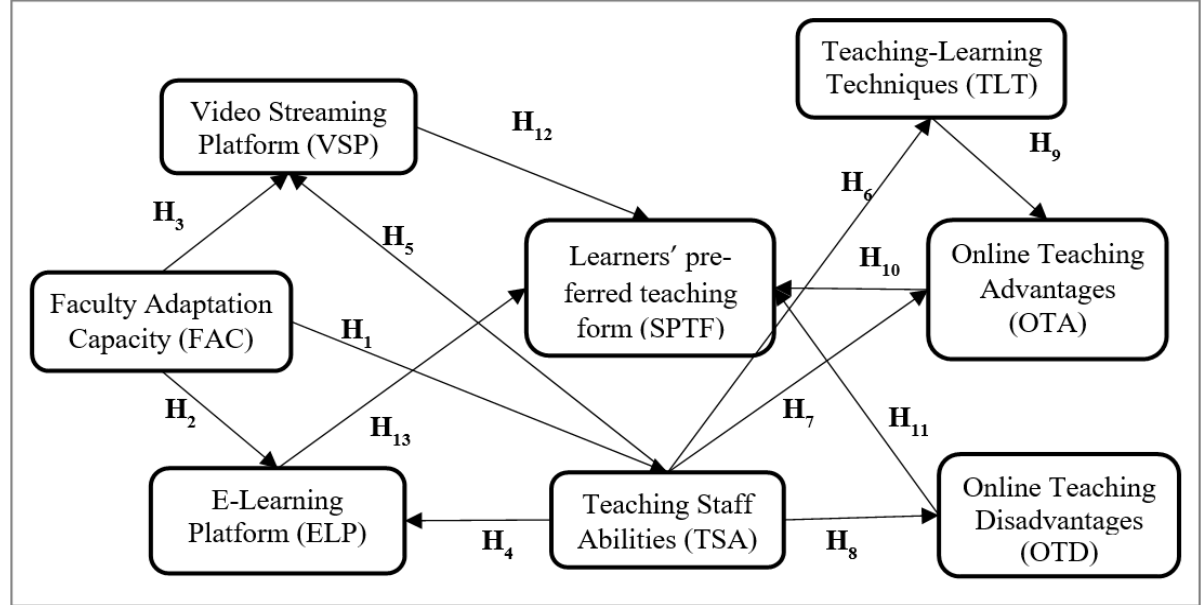
Figure 1. The conceptual model: Learners’ preferred teaching form during the COVID-19 pandemic. Source: own development.